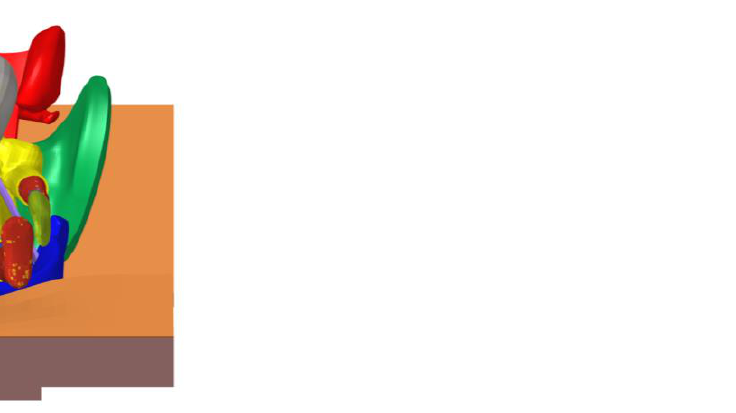
Figure 7. Simulation illustration of severe injury in a child’s neck during a frontal crash due to seatbelt slippage.